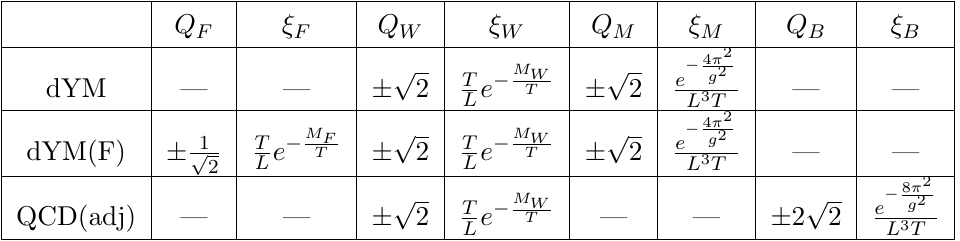
Table 1 . Charges and fugacities of the electric and magnetic components in each